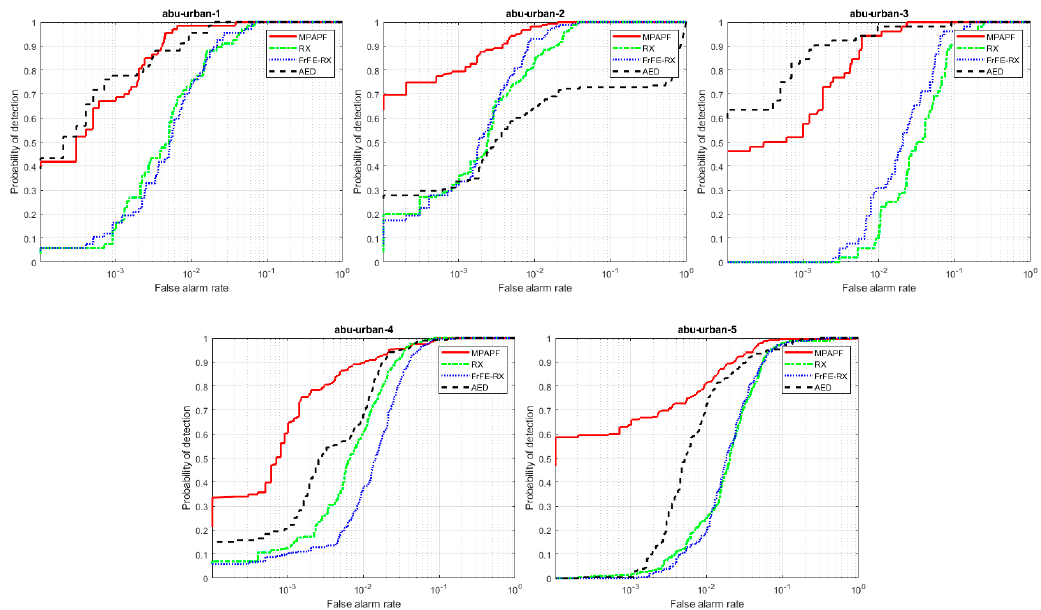
Figure 9. ROC curves of the compared methods on the ABU-Urban Scene.